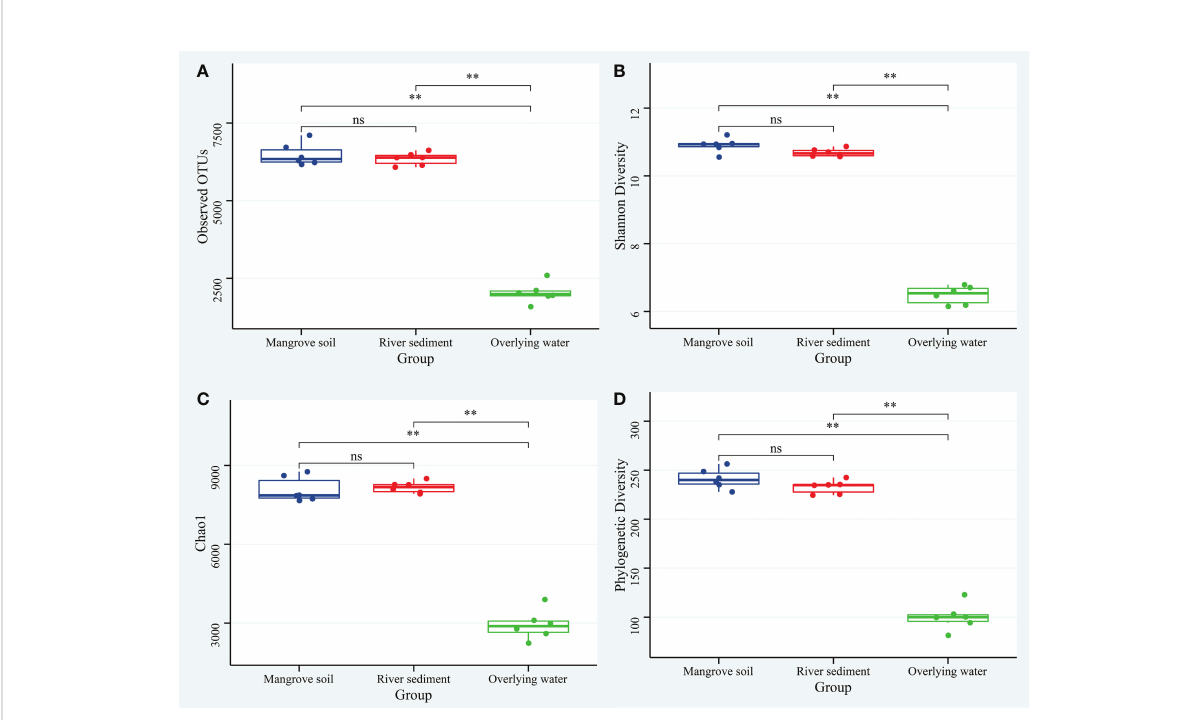
FIGURE 1 The alpha diversity indices of the bacterial communities in the mangrove soil, river sediment and overlying water. (A) observed OTUs; (B) Shannon diversity; (C) Chao1 diversity; (D) Phylogenetic Diversity. Signi fi cance of the one-way ANOVA tests: ns, not-signi fi cant; ** p <